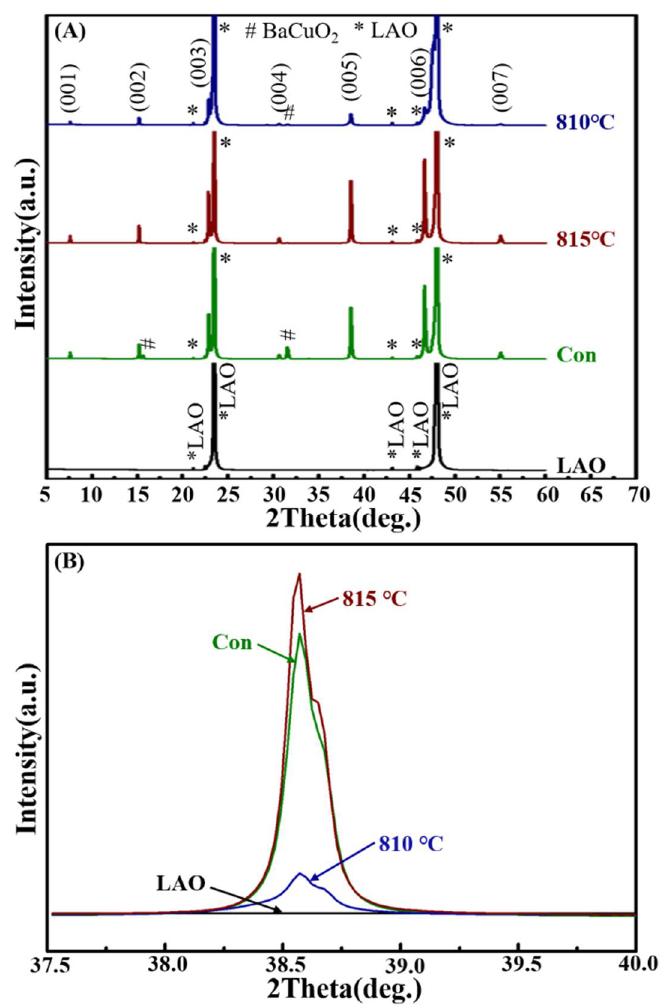
Figure 8. ( A ) The θ -2 θ X-ray diffraction patterns of low-vacuum pyrolysis films after high-temperature treatment at 810 ◦ C and 815 ◦ C for 30 min. ( B ) Relative intensity of (005) peaks. Raman spectra were conducted to investigate the growth orientation of YBCO films (Figure 9). The O(2,3) anisotropic vibration-related peak in the Cu-O plane of the film is at 340 cm −1 , which represents the c -axis out-of-plane growth of the film [23]. The peak